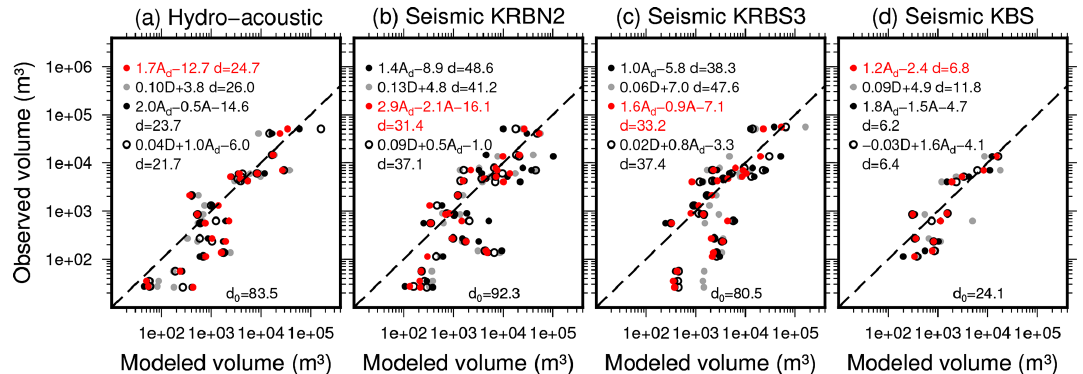
Figure 3. Generalized linear models (GLMs) relating waveform properties to calving volume (lidar scanning) of individual events. Models are calibrated for different stations and combinations of calving signal features ( D : signal duration; A d : amplitude integrated over event duration; A : maximum amplitude). Model coefficients, deviance ( d ), and null deviance ( d 0 ) of each model are stated. Red symbols show the best-performing models. Dashed lines indicate equality of modeled and observed